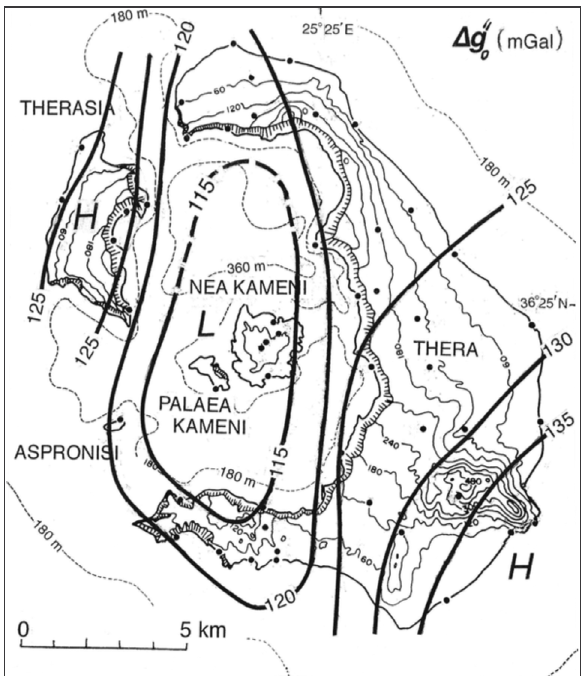
Figure 1. Santorini caldera, Greece: the Bouguer gravity anom- alies are shown after Yokoyama and Bonasia [1978]. Solid dots show gravity points. H and L denote residual anomalies, high and low, re-